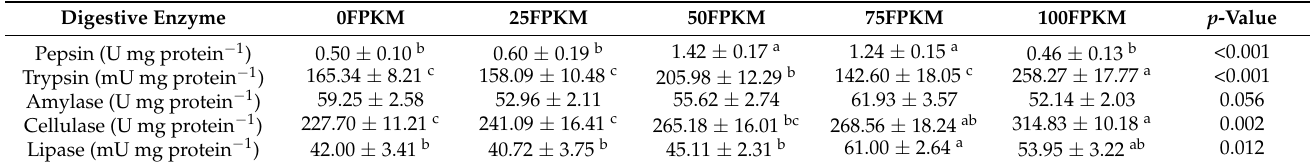
Table 4. Digestive enzyme activity of sex-reversed red tilapia fed with experimental diets containing varying levels of FPKM for 12